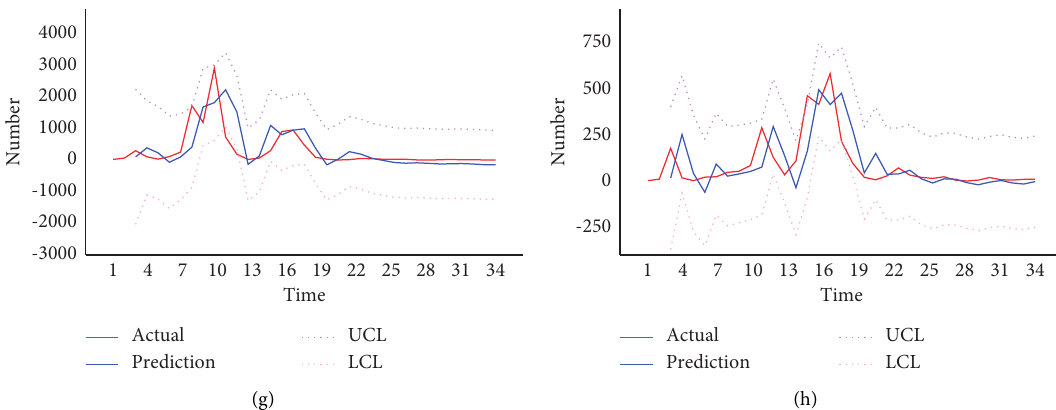
Figure 5: Actual and predicted values of ARIMA model in positive sentiment. (a) Natural disaster 1. (b) Natural disaster 2. (c) Accident 1. (d) Accident 2. (e) Public health 1. (f) Public health 2. (g) Social security 1. (h) Social security